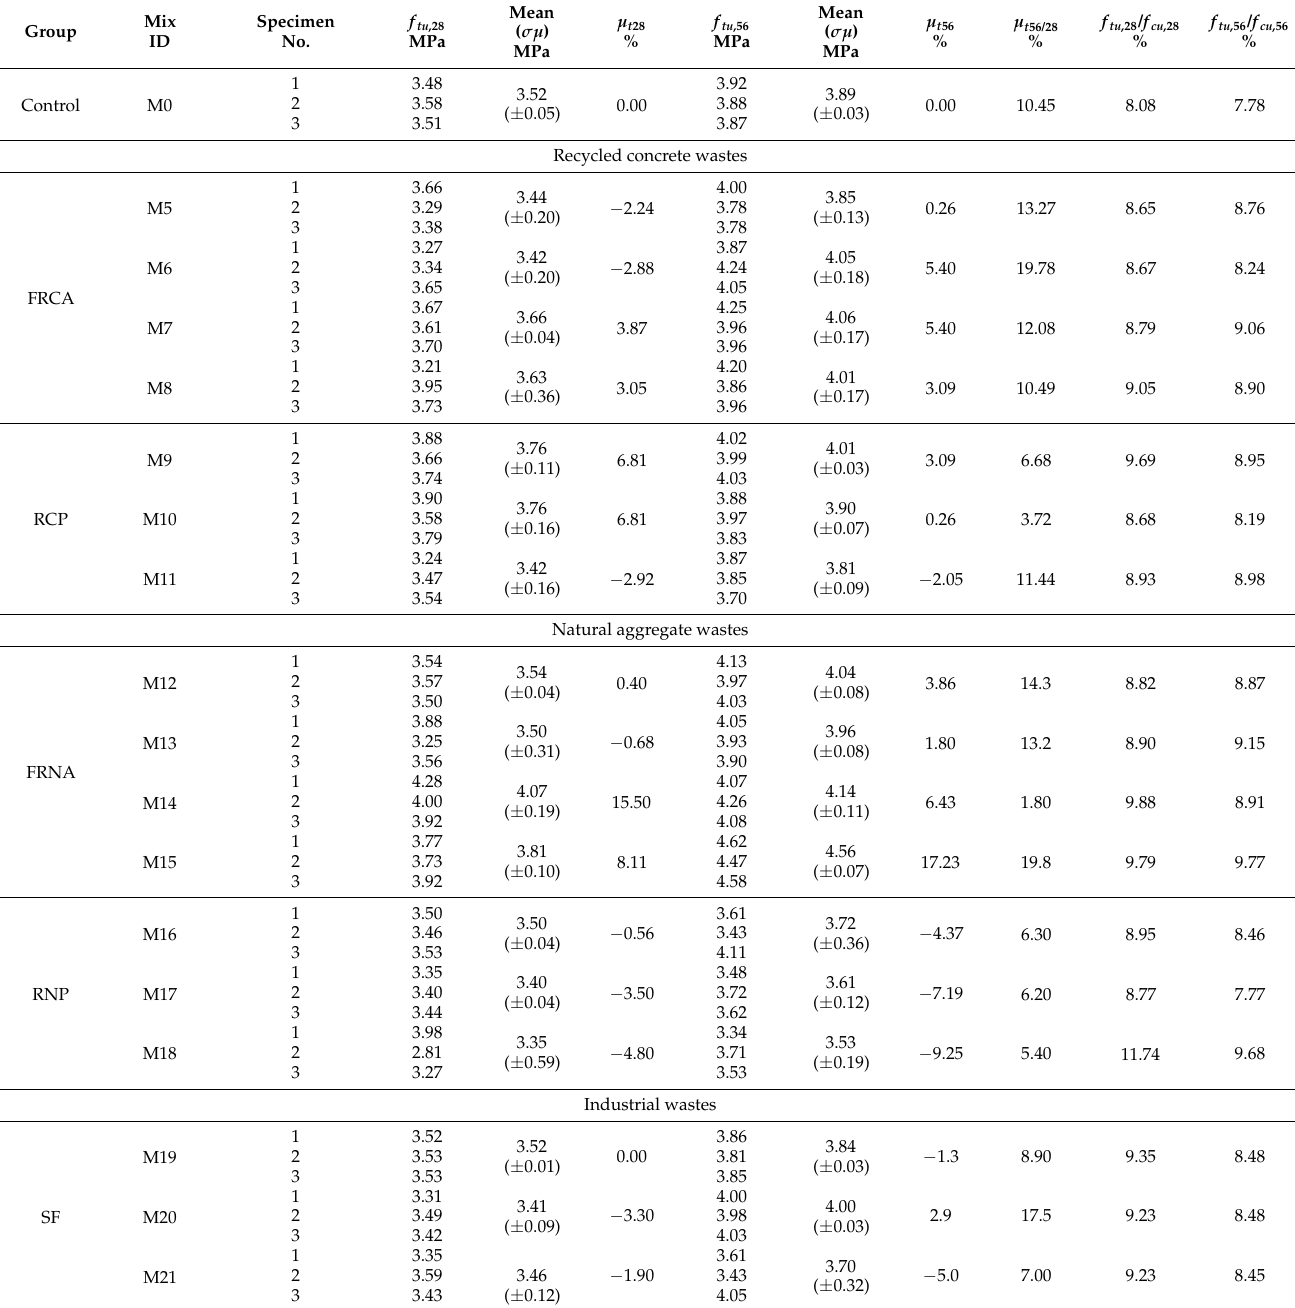
Table 5. The concrete tensile strength for all mixes at 28 and 56